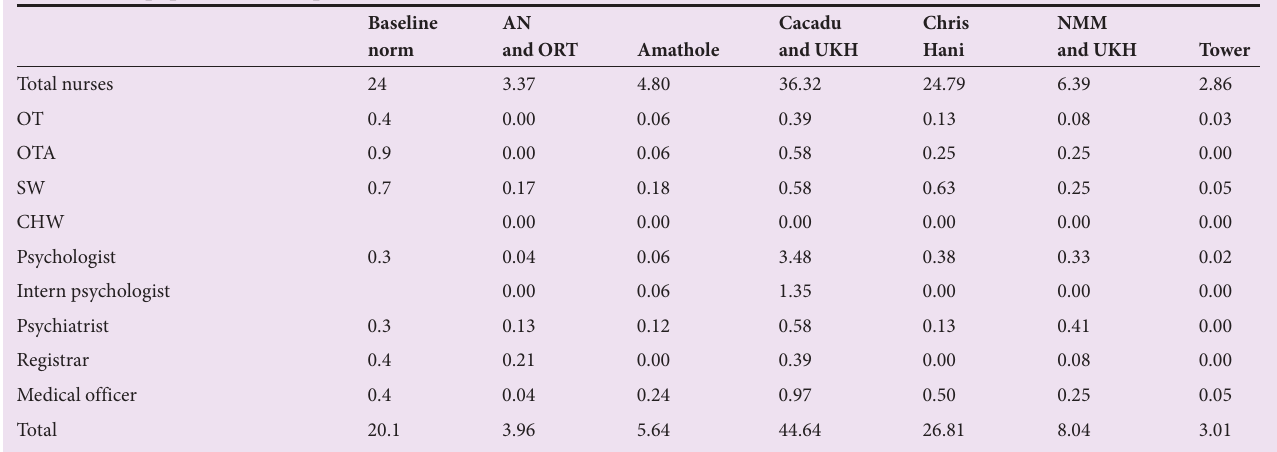
Table 4. Staff/population ratios per district